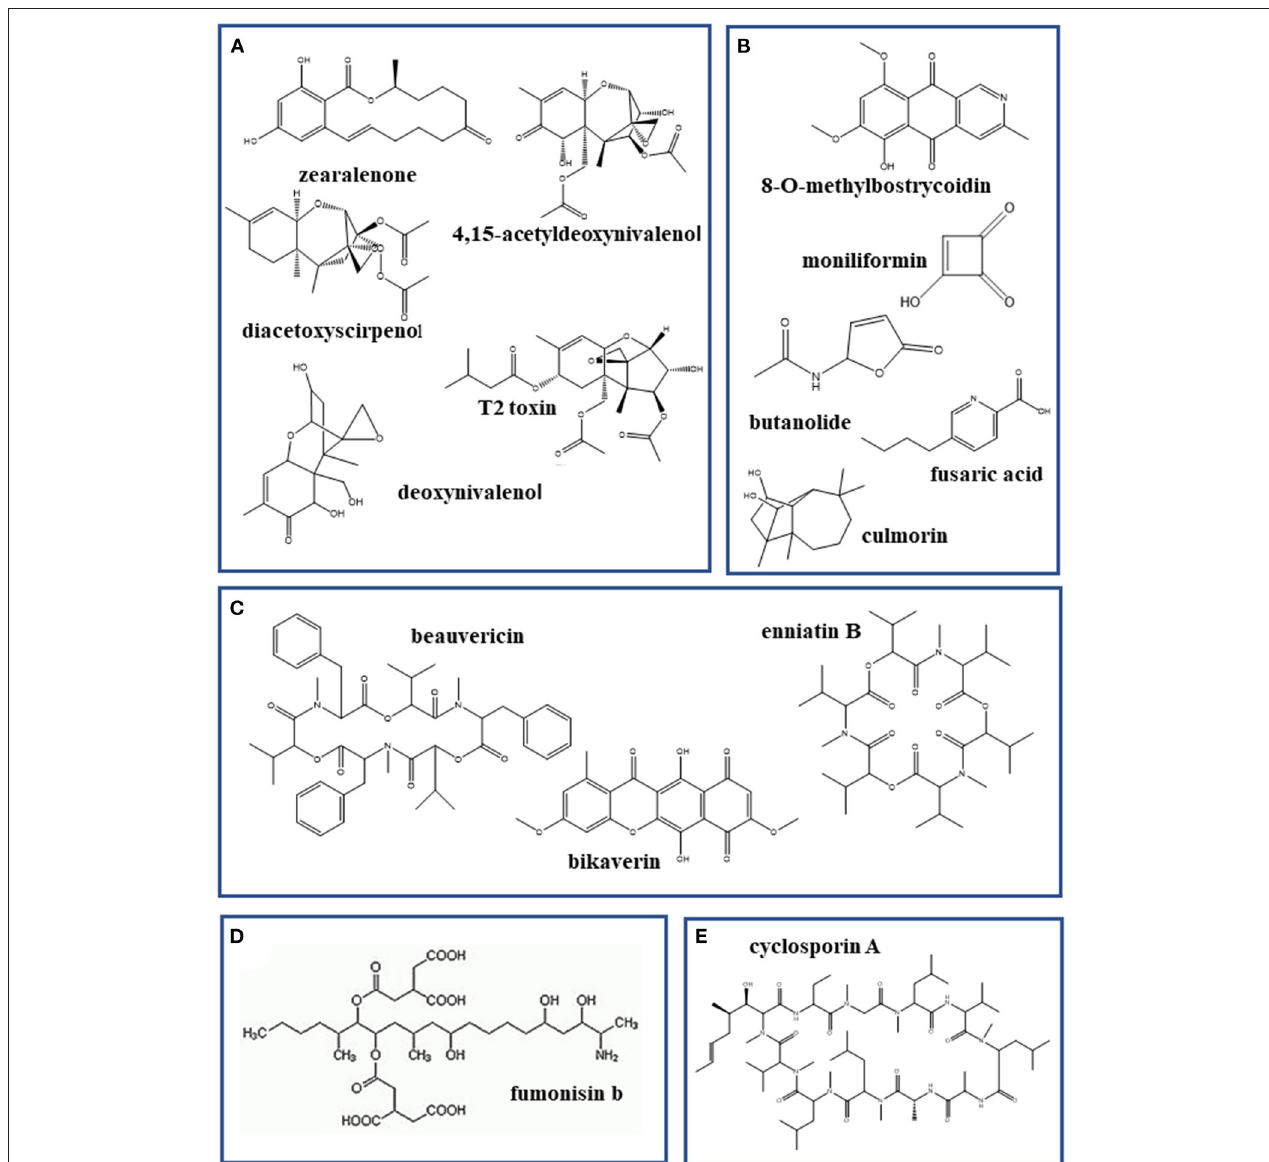
FIGURE 3 | Selected mycotoxins produced by species of Fusarium pathogenic on Cannabis sativa . (A) Trichothecene mycotoxins; (B) emerging mycotoxins; (C) emerging mycotoxins with known ionophoric activity; (D) fumonisins; and (E) cyclosporine.